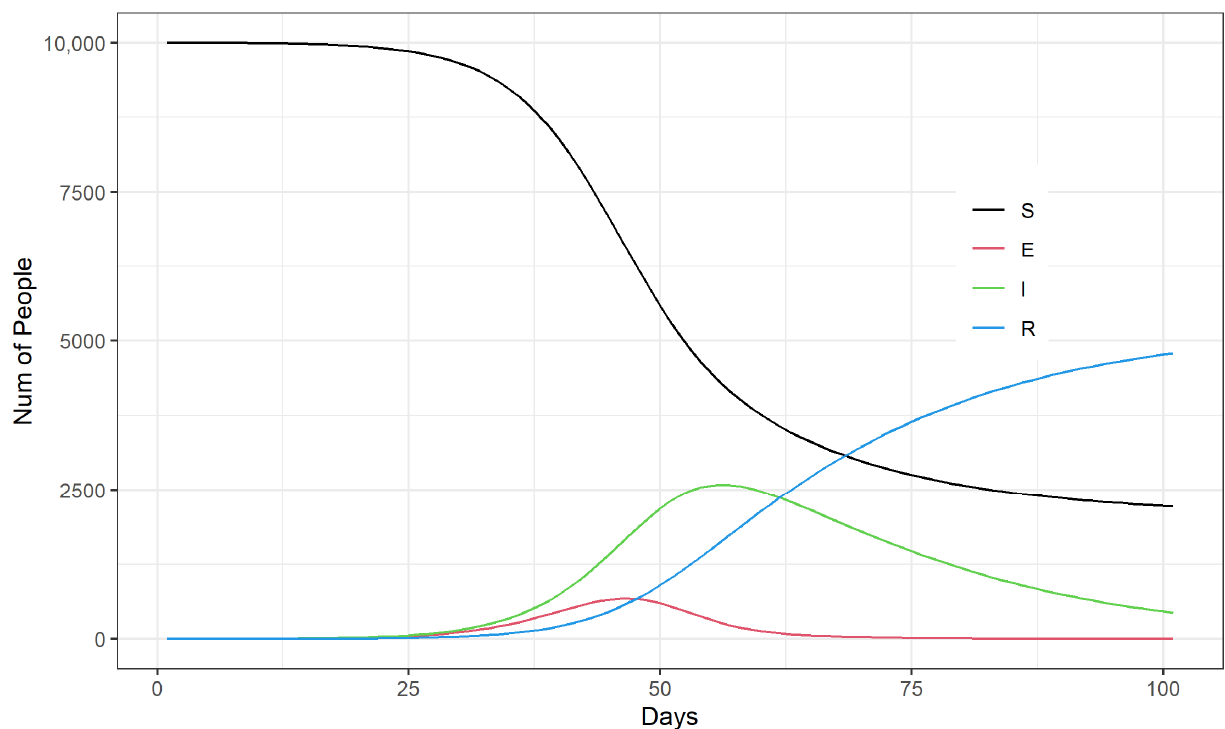
Figure A4. The influence of the daily testing capacity of 1000 person on the evolutionary process of the epidemic; (The unit of the ordinate is “person”).